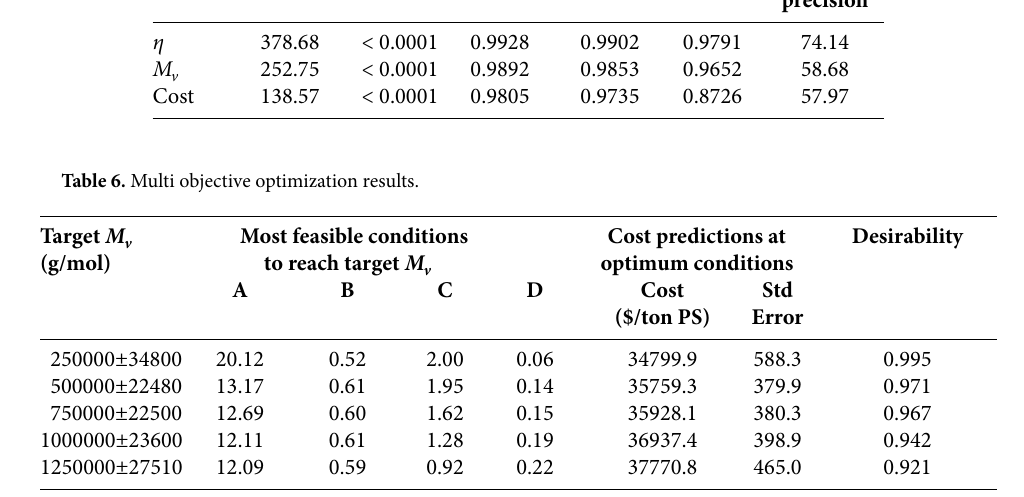
Table 5 . Statistical indicators of the intrinsic viscosity, molecular weight and cost mod- els. Model F-value